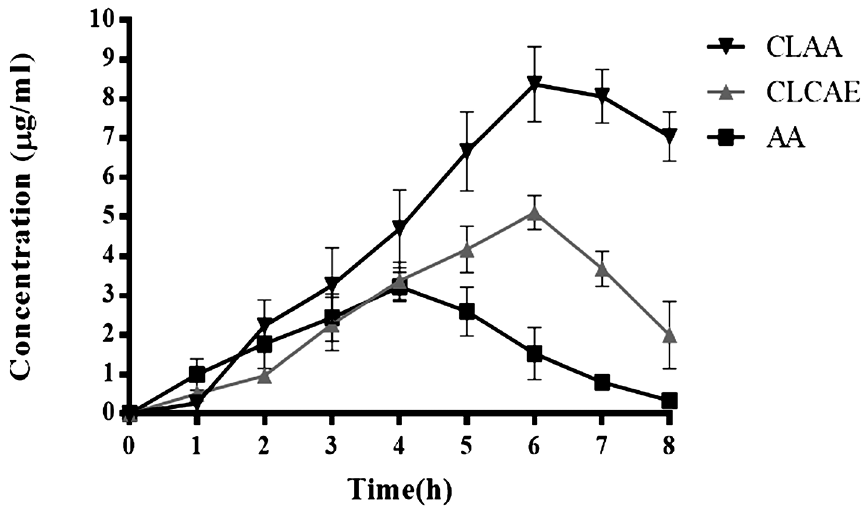
Figure 12. In vivo pharmacokinetic study of A) AA B) CLCAE and C) CLAA (n=6).